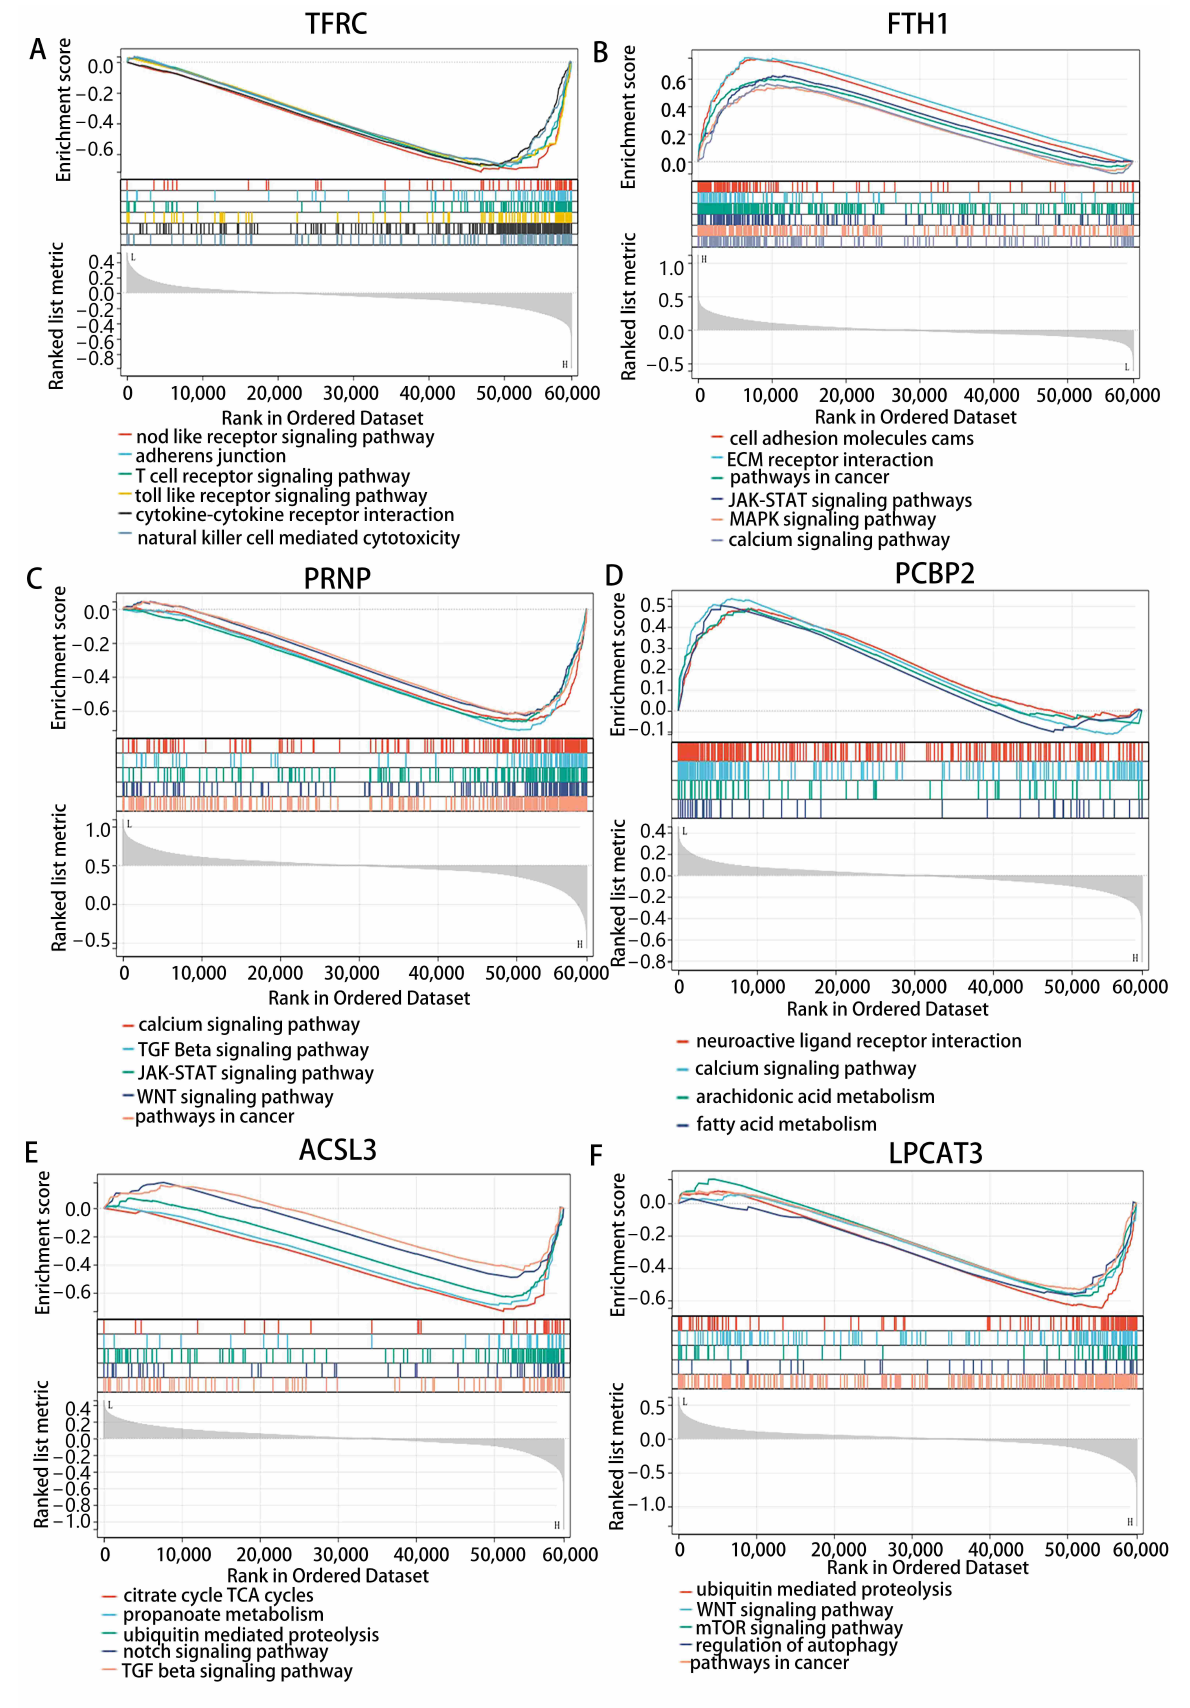
FIGURE 7. The enriched pathway analysis by GSEA in PRAD. (A) TFRC. (B) FTH1. (C) PRNP. (D) PCBP2. (E) ACSL3. (F)